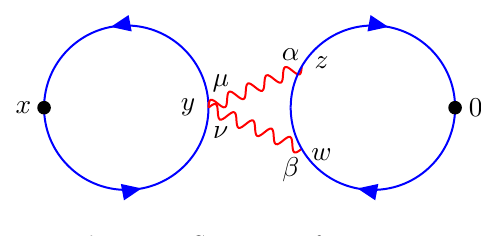
Figure 7 . Symmetry factor is